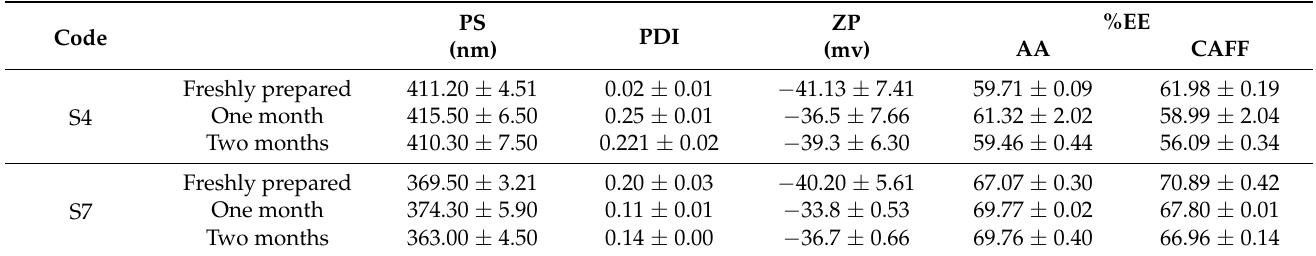
Table 4. The short-term stability results of S4, and S7 at 4 ◦ C for 2 months. PS, PDI, ZP and %EE studied as stability parameters. Results are represented by mean ± SD (n =